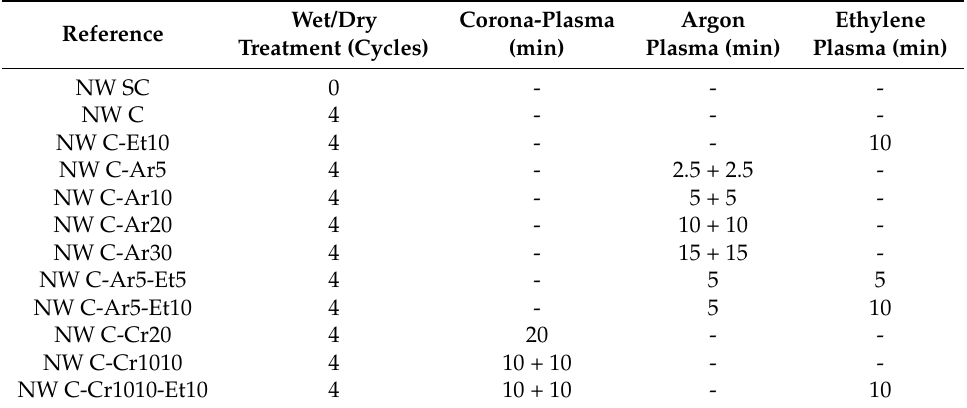
Table 1. Sample references and description of the treatment conditions applied.